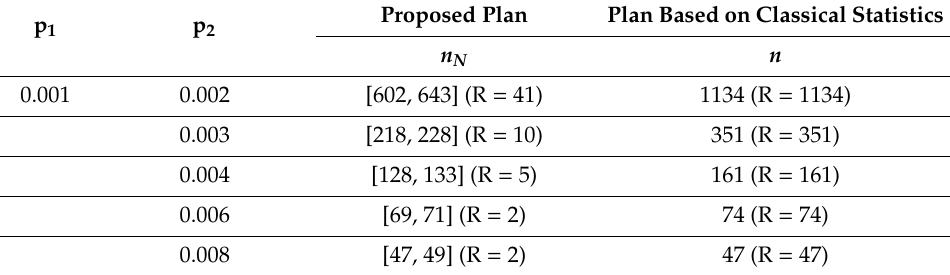
Table 2. The comparison of proposed plan and the plan based on classical